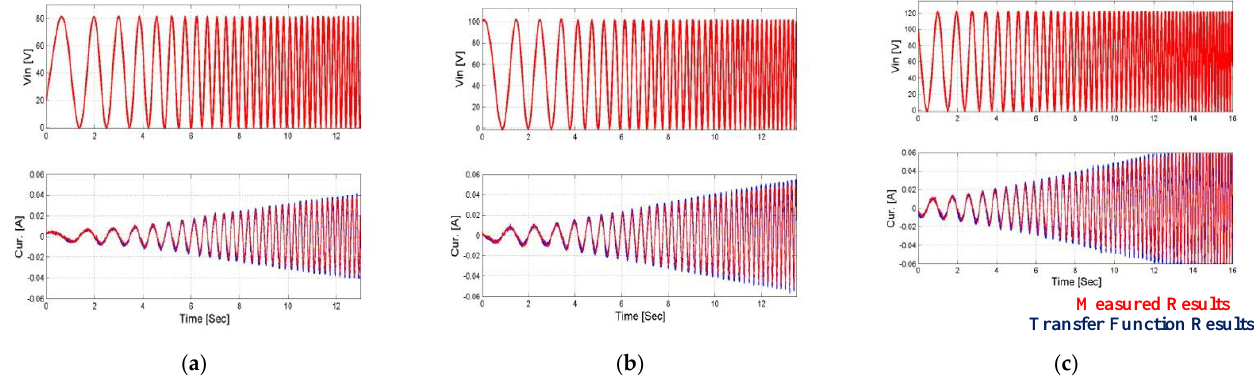
Measured Results Transfer Function Results